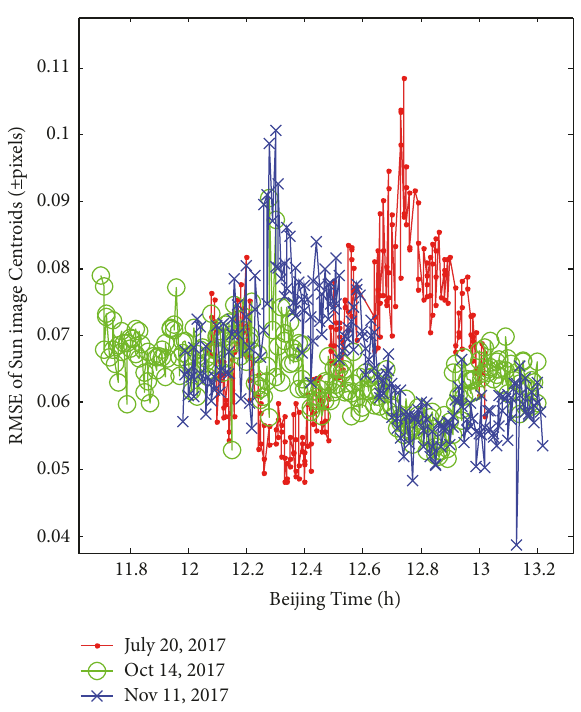
Figure 14: Mean square error series of sun image